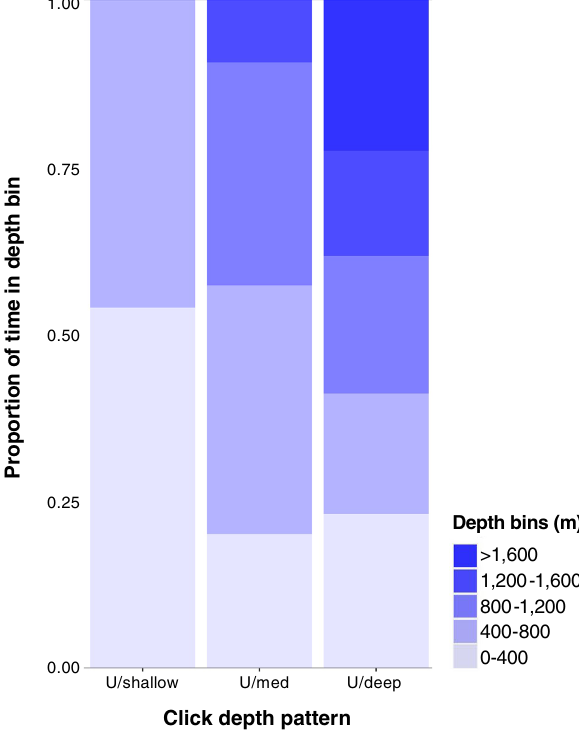
Figure 6. Proportion of time recorded in 400 m depth bins or at depths > 1600 m for events categorized based on patterns in click depths U shaped and shallow (n = 10), U shaped and medium (n = 25), or U shaped and deep (n =